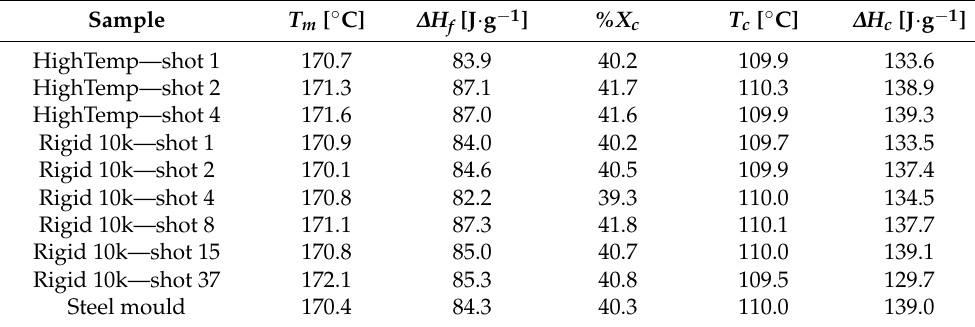
Table 3. Thermal phase transitions of PP samples moulded using different tool